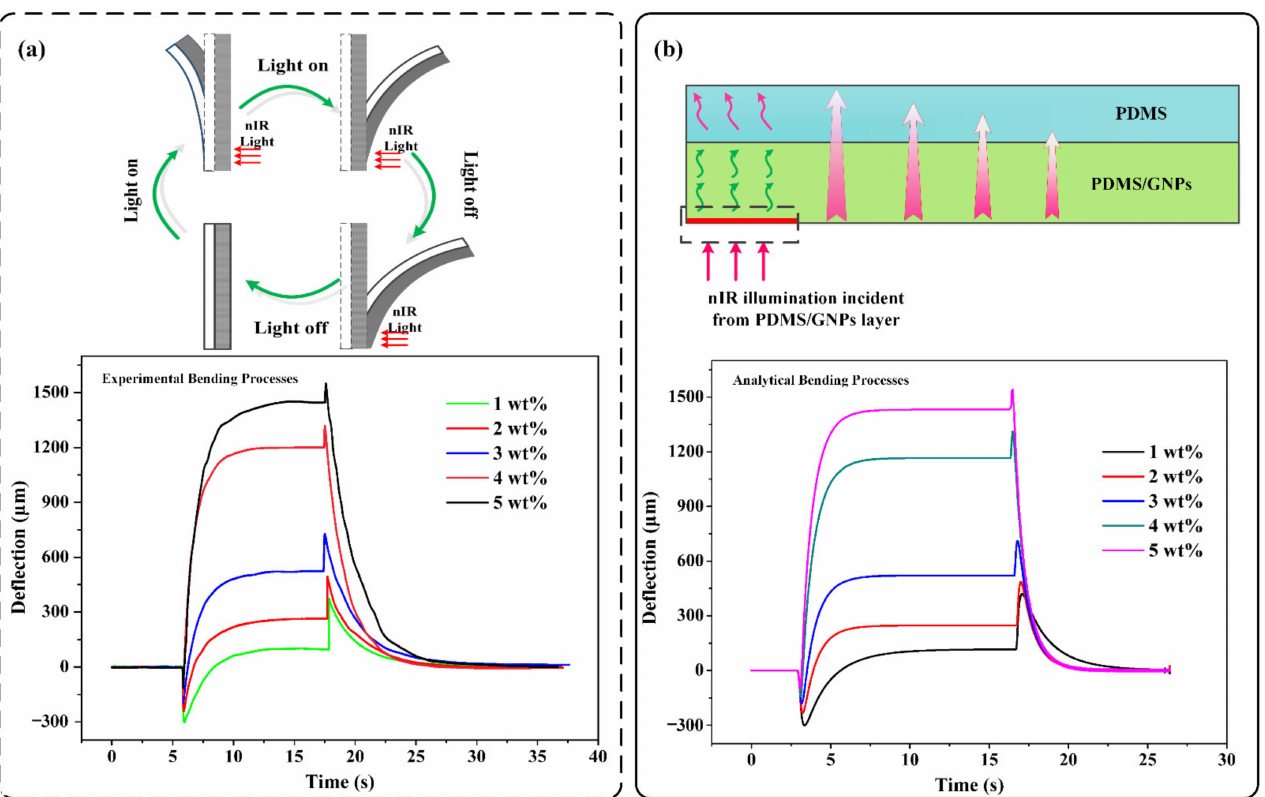
Figure 2. Two-step photomechanical bending of soft bilayers. ( a ) Experimental measurement of photomechanical bending of the soft bilayer. ( b ) Simulation of the two-step photomechanical bending with the help of COMSOL Multiphysics